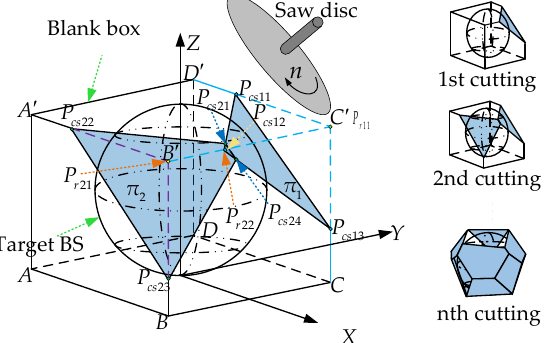
Figure 2. Schematic diagram of block cutting.